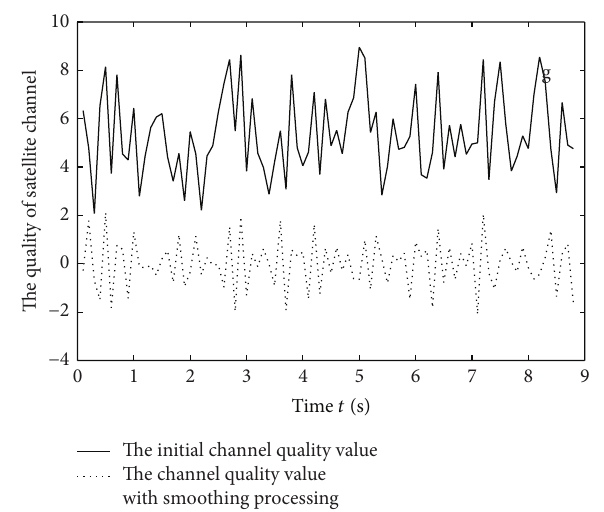
Figure 7: The prediction data of satellite channel quality with smoothing processing.